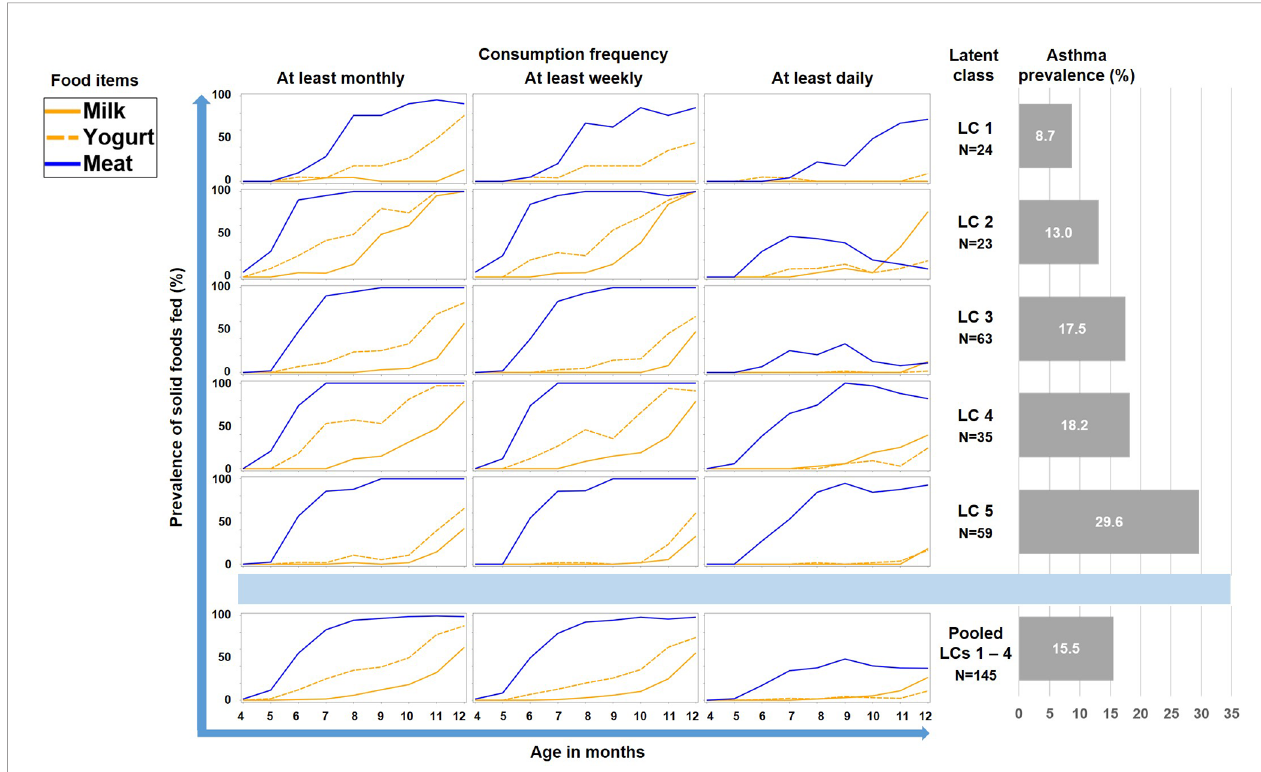
FIGURE 7 | Food introduction styles in LUKAS2 as de fi ned by a latent class analysis of consumption of meat, milk, and yoghurt over 9